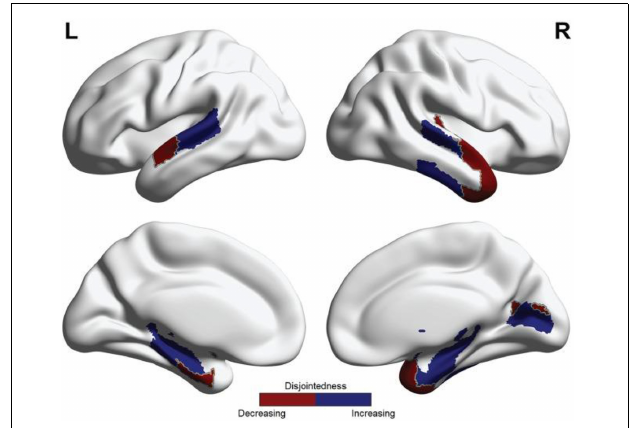
FIGURE 4 | Reprinted with permissions from (Telesford et al., 2017). Patterns of changing disjoint flexibility as associated with learning. Blue indicates regions where disjointedness increased between Day 1 and Day 2 of the motor learning task, and red indicates regions where disjointedness decreased between Day 1 and Day 2 of the motor learning